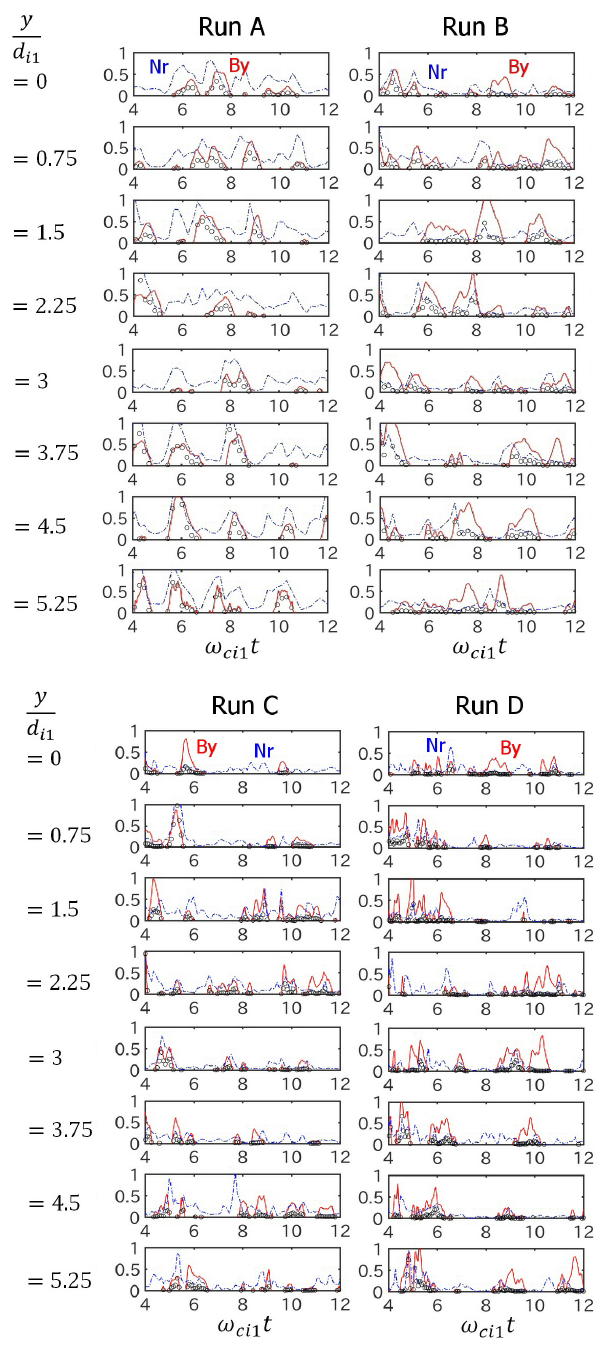
Figure 4. Temporal variation of the shock magnetic field B y −(cid:104) B y (cid:105) (solid lines), and density of reflected ions N r (dash–dotted lines) in the foot region for Runs A–D with the large simulation domain. Here, (cid:104) B y (cid:105) represents the averaged shock magnetic field for the time interval of ω ci1 t = 4–12. The indicator of the foot formation defined in Eq. (5) is shown by